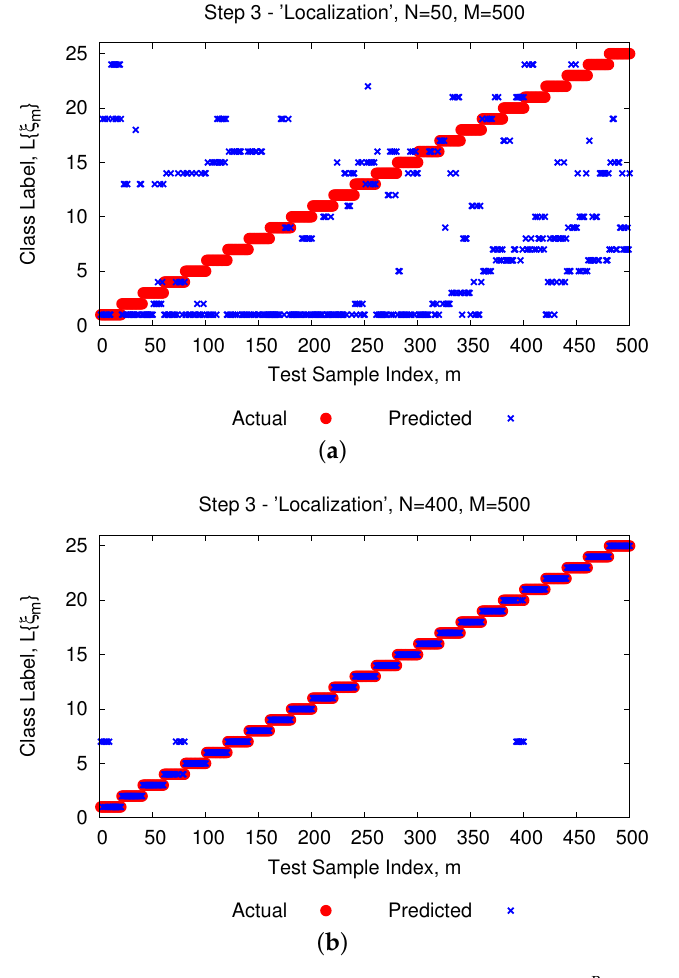
Figure 9. Experimental Assessment. ( V = 8, f 0 = 900 MHz, (cid:101) ε B = 41.8 ε 0 − j 0.97 S = 48.63 ε − j 1.28 , M = 500, P = 25)—Actual vs. predicted labels when solving Step 3 (“Localiza- (cid:101) ε 0 H 2 π f 0 tion”) through a multi-class SVM approach with ( a ) N = 50 and ( b ) N = 400 training samples.